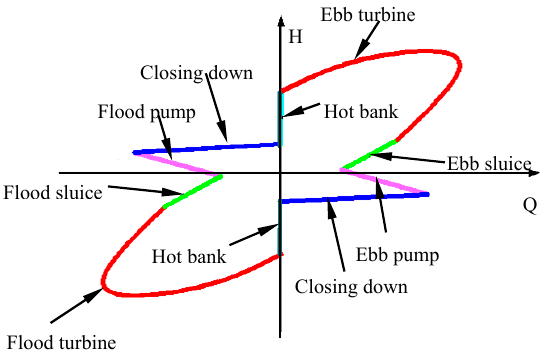
Figure 2. Four quadrant sketch of tidal unit operating condition transitions.